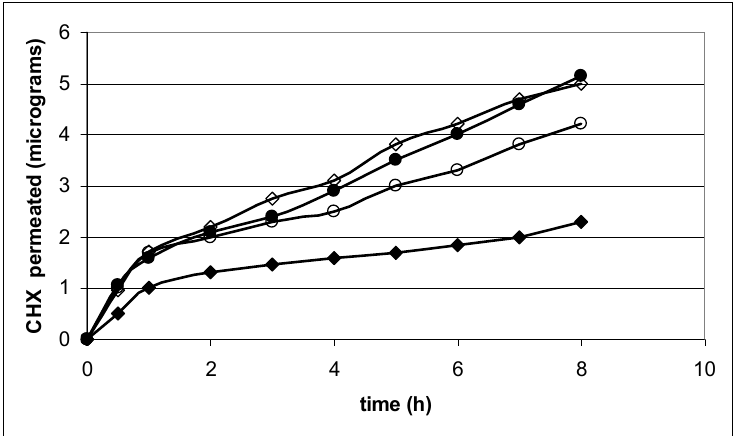
Figure 4. Permeation profile of CHX from Gels: 1 ♦ ; 5 ◊ ; 6 ● ; 8 ○ , using a modified Franz cell.